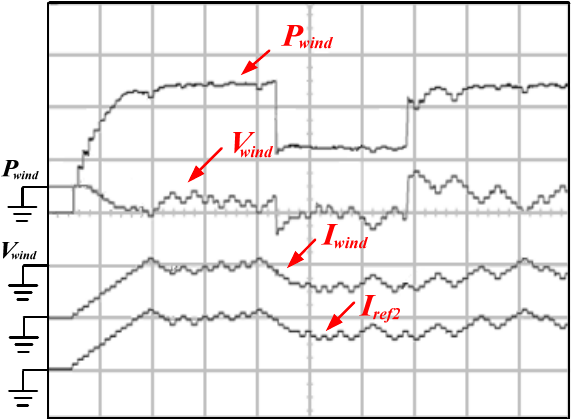
Figure 22. Measured output voltage, current and power waveforms of wind turbine at variable : 100 W/div, V : 200 V/div, I : 2 A/div, I : 2 V/div, time : 10 s/div). MPPT. ( P wind wind wind ref2